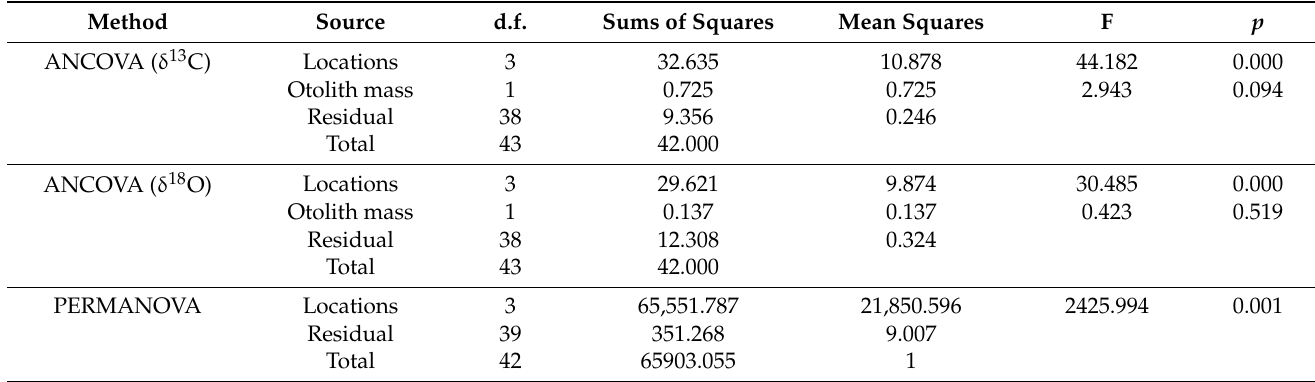
Table 2. Summary of ANCOVA and PERMANOVA ( δ 18 O and δ 13 C) results across all locations of Schizothorax kozlovi based on Type III sums of squares of the standardized